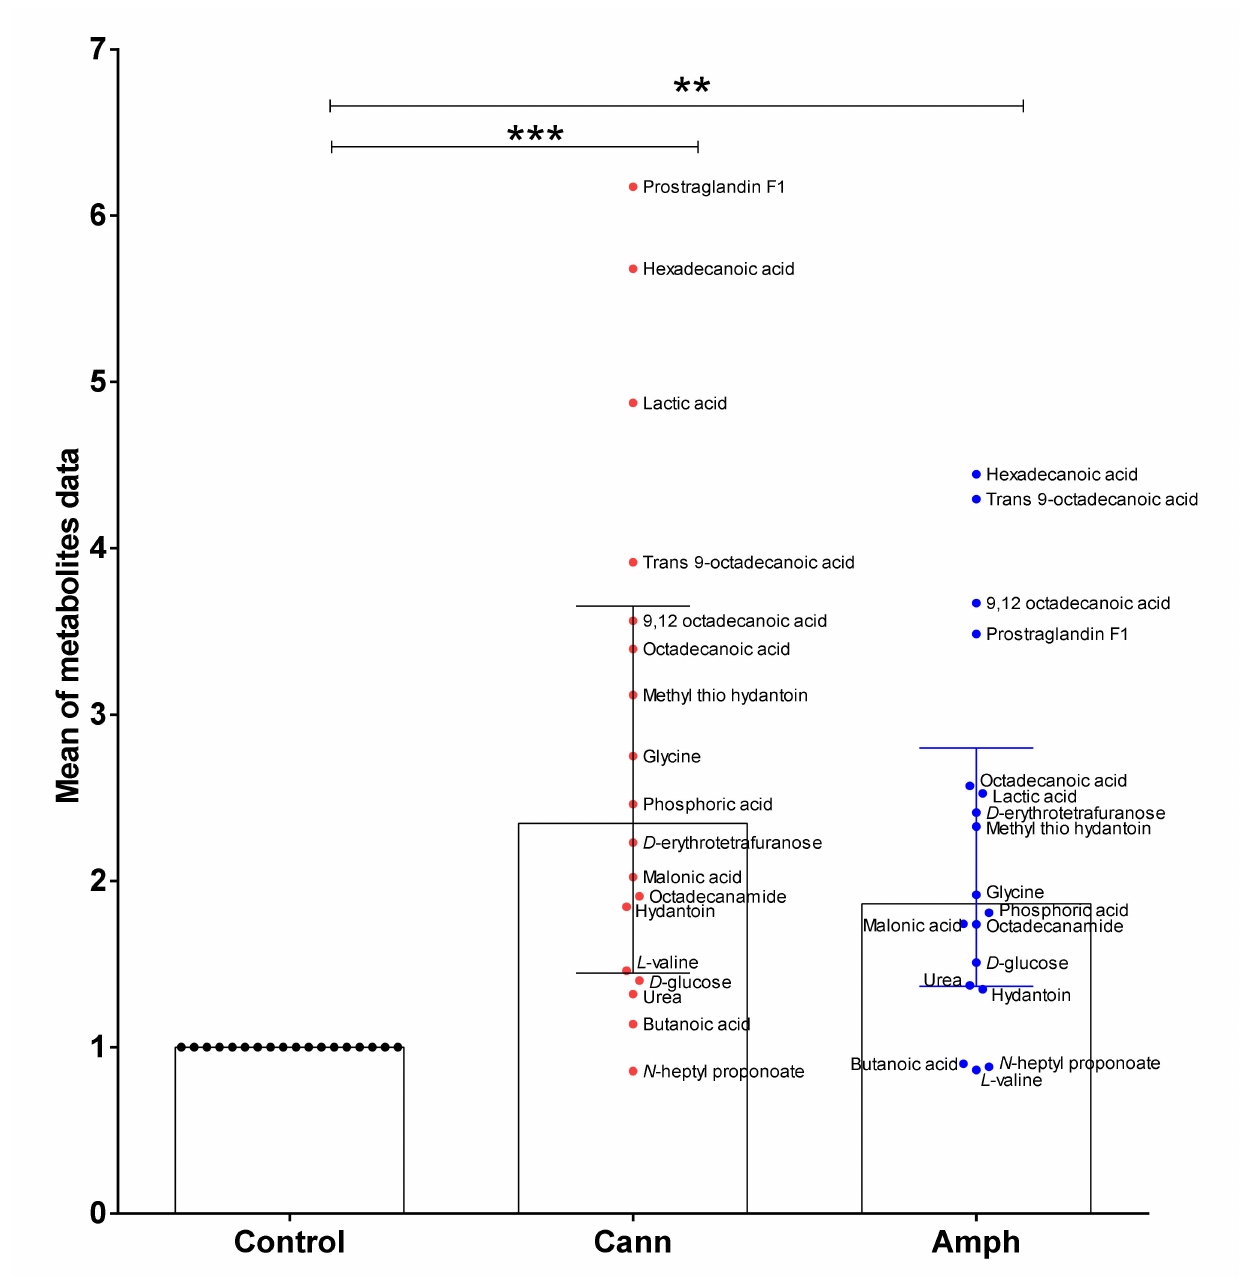
Figure 8. Kruskal–Wallis test followed by Dunn’s post hoc analysis showed that the metabolomic profiles of amphetamine or cannabis use disorder patients are significantly different than control group. Data are expressed as median with interquartile range. (** p < 0.01, *** p < 0.001). Each dot represents mean of one metabolite in each group. Cann, cannabis. Amph,